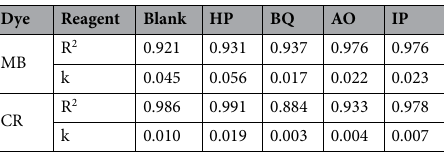
Table 4. Variation in best fit degradation kinetic parameters of MB and CR in the presence different scavengers and